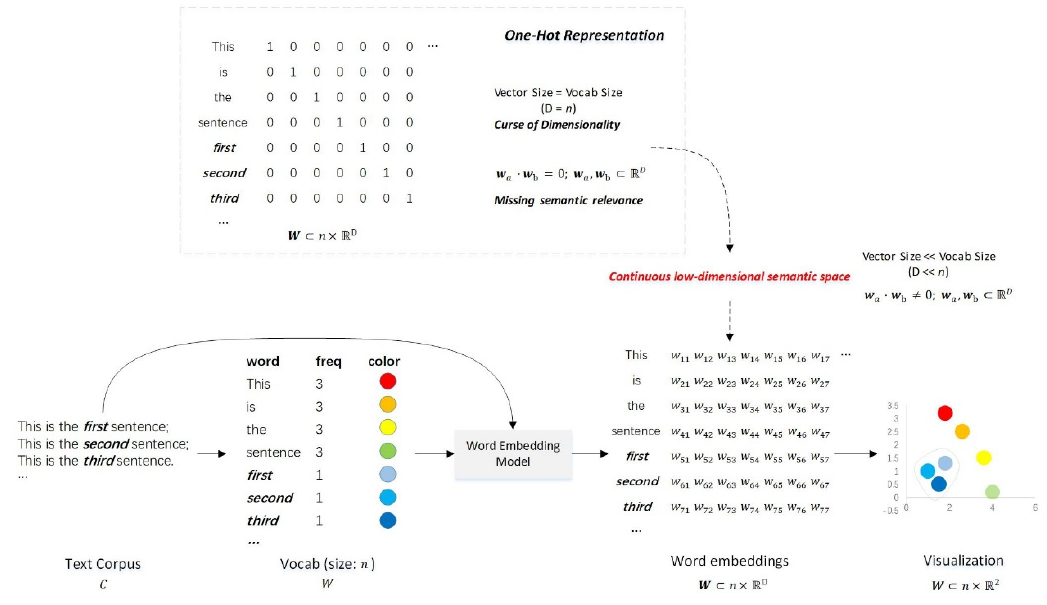
Figure 3. Word embedding workflow.